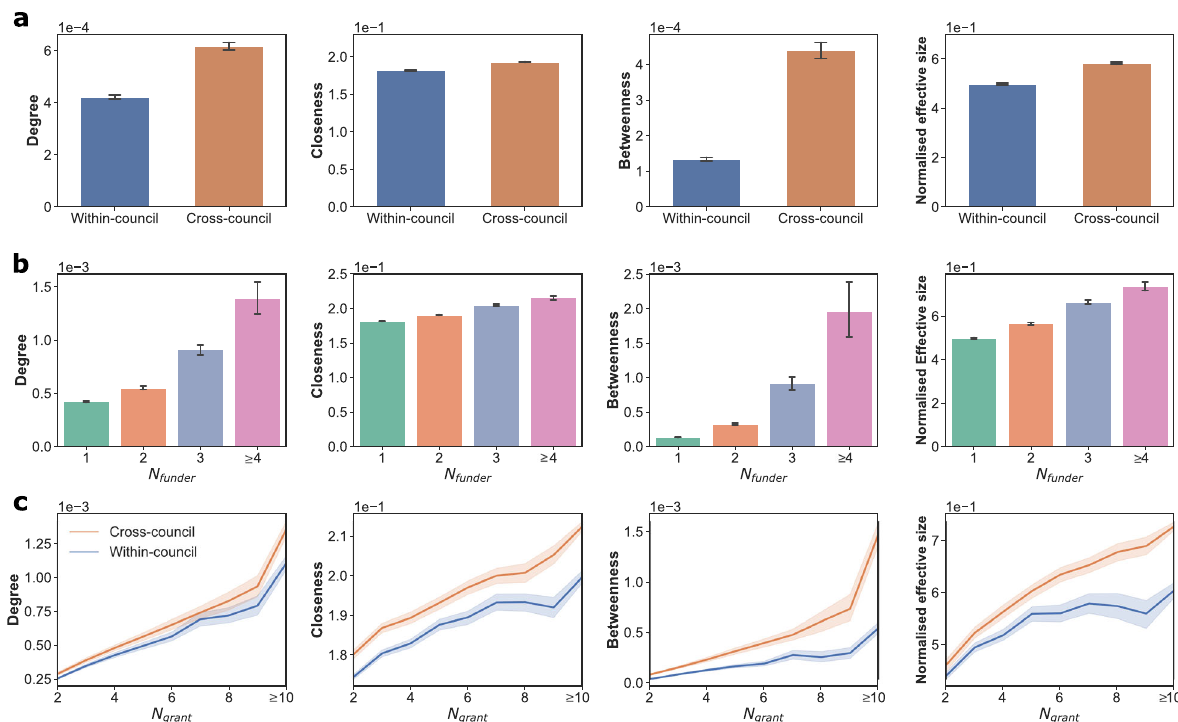
Fig. 2 Structural advantage of cross-council investigators in the collaboration network. Each column corresponds to a different network property, namely: degree centrality, closeness centrality, betweenness centrality and normalized effective size. a Cross-council investigators signi fi cantly outperform the within-council investigators in all four network properties (Welch ’ s t -test, p < 0.001 in all cases). b Network metrics among investigators increase with the number of councils ( N funder ) they have received funding from. c Cross-council investigators consistently have a network advantage over within-council investigators with reference to degree, closeness, betweenness and normalized effective size. N grant denotes the number of grants received by investigators in cross-council and within-council groups. The error bars and shaded areas represent 95% con fi dence